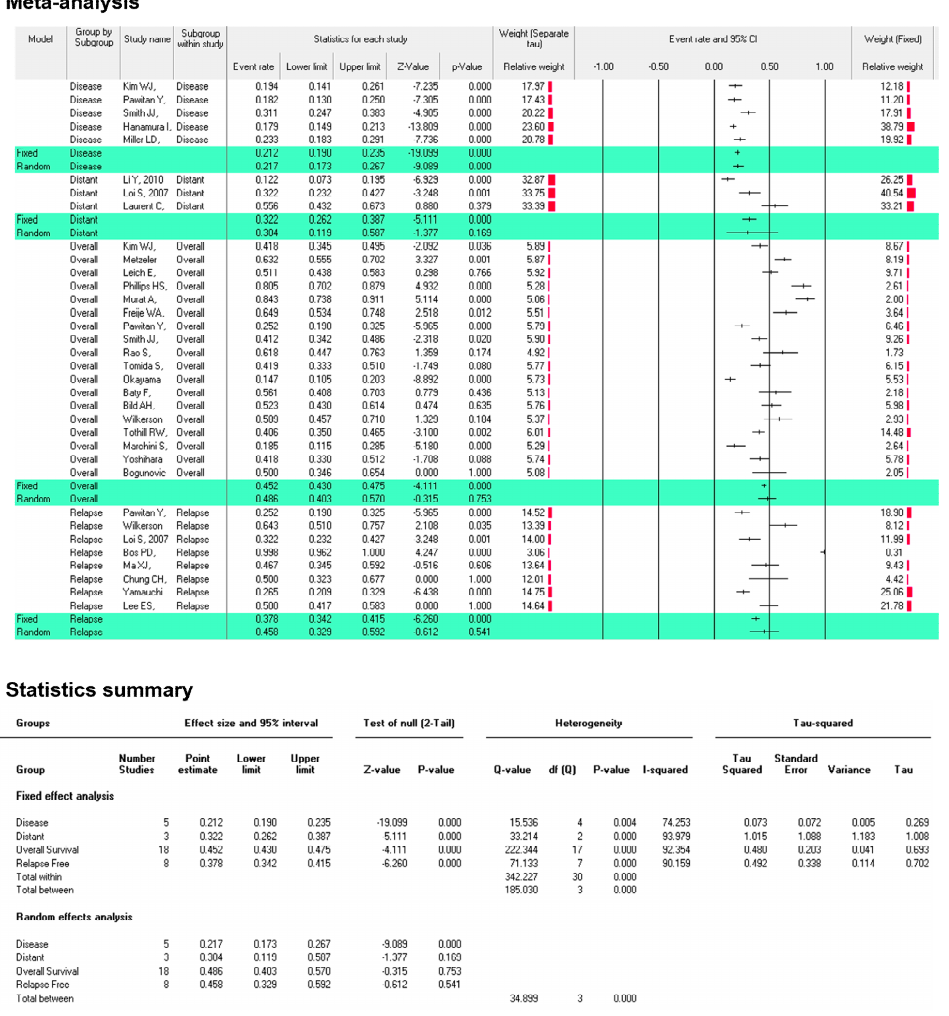
Figure 5. Event rate as cancer risk for overall, disease specific survival, relapse free survival, distant metastasis free survival based on Fixed and Random effect model. Meta-analysis: To further elucidate the comparison of hazard rate in order to OS, DSS, DFS and RFS. We have scrutinized selected 34 eligible studies according to SERTAD1 expression and patient’s survival.